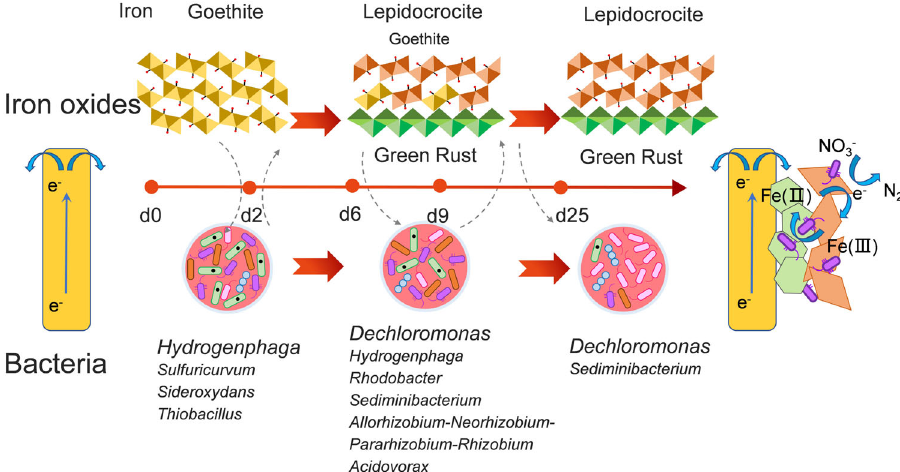
Fig. 6 Timeline of microstructure formation by the synergistic evolution of iron oxides and bacteria. To achieve electron rebalancing of the system, corrosion occurs on the surface of the iron rod, accompanied by the transformation of the bacterial community. Iron oxides and the bacterial community synergistically assemble to form the microstructure, which promotes electron transfer from the surface of the iron rod to nitrate in the overlying